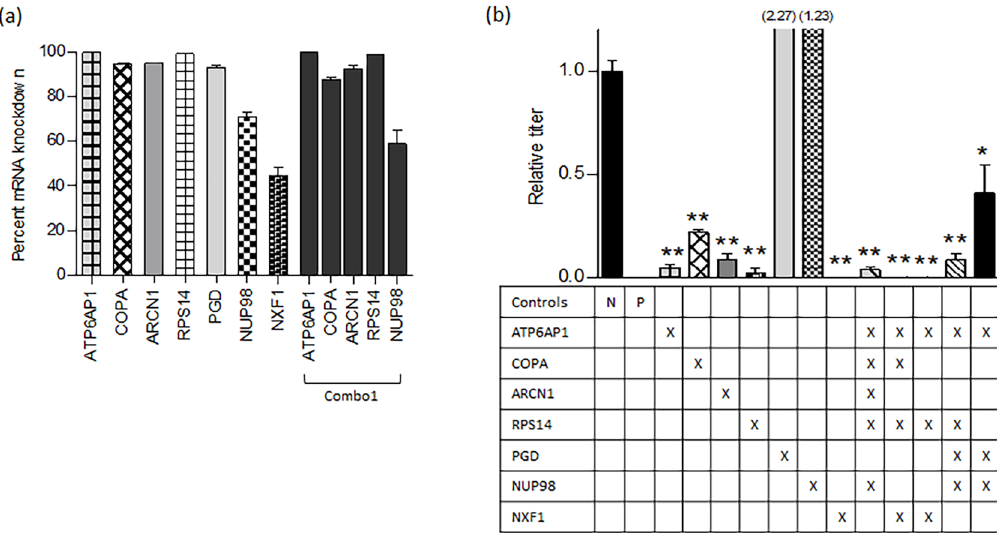
Fig 3. siRNA knockdown of mRNA in NHBE and the impact on influenza A/WSN/1933 (WSN) replication. (a) Knockdown efficiency of siRNA in NHBE cells; the components within Combo1 are shown as a representative example. Bars represent mean (+ SEM) knockdown relative to non-targeting siRNA 24 hours post transfection. Knockdown data for additional combinations of targets is presented in S1 Table. (b) Inhibition of viral replication when genes were targeted singly, or in combination. For each bar, the targeted genes are shown (X) below. The Allstars negative control (N) and siNP positive control (P) are shown. Results are displayed as normalized to viral growth in cells transfected with non-targeting siRNA. ( (cid:3) p < 0.05, (cid:3)(cid:3) p < 0.01). NHBE cells were transfected with siRNA 24 hours after plating. Cells were infected with WSN virus (MOI = 0.2) 24 hours following siRNA transfection and incubated for 48 hours prior to evaluating viral titer by plaque